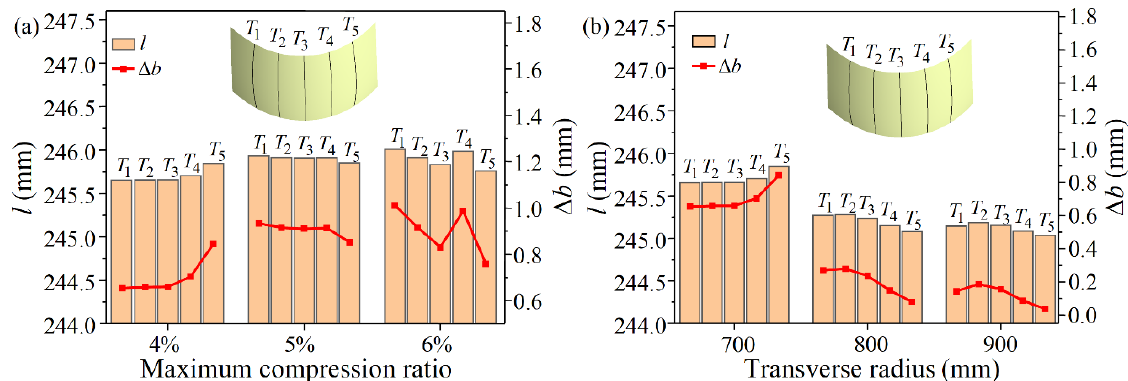
Figure 3. Comparison of the transverse dimensions of the sheet before and after rolling: ( a ) Under the condition of different maximum compression ratios; ( b ) Under the condition of different transverse radii.